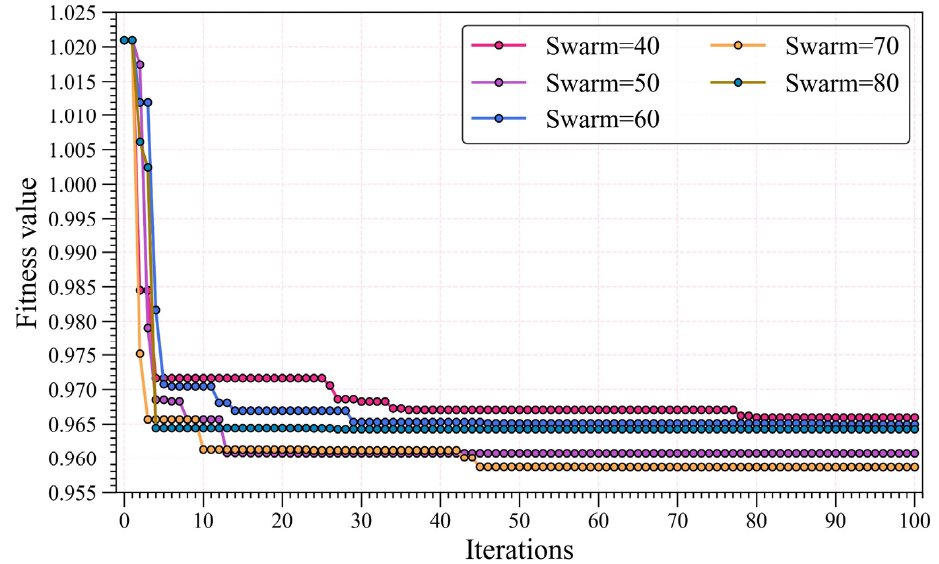
Figure 8. The fitness variation during the optimization process.